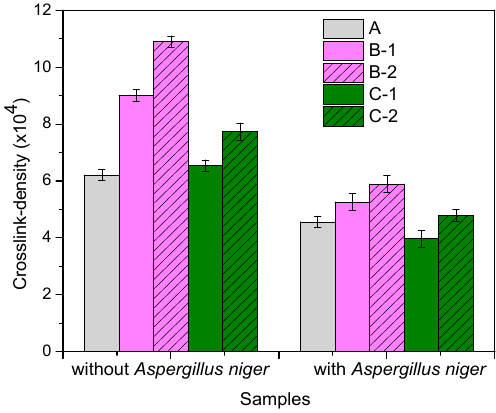
Figure 5. Cross-link density of the composites before and after incubation with Aspergillus niger .